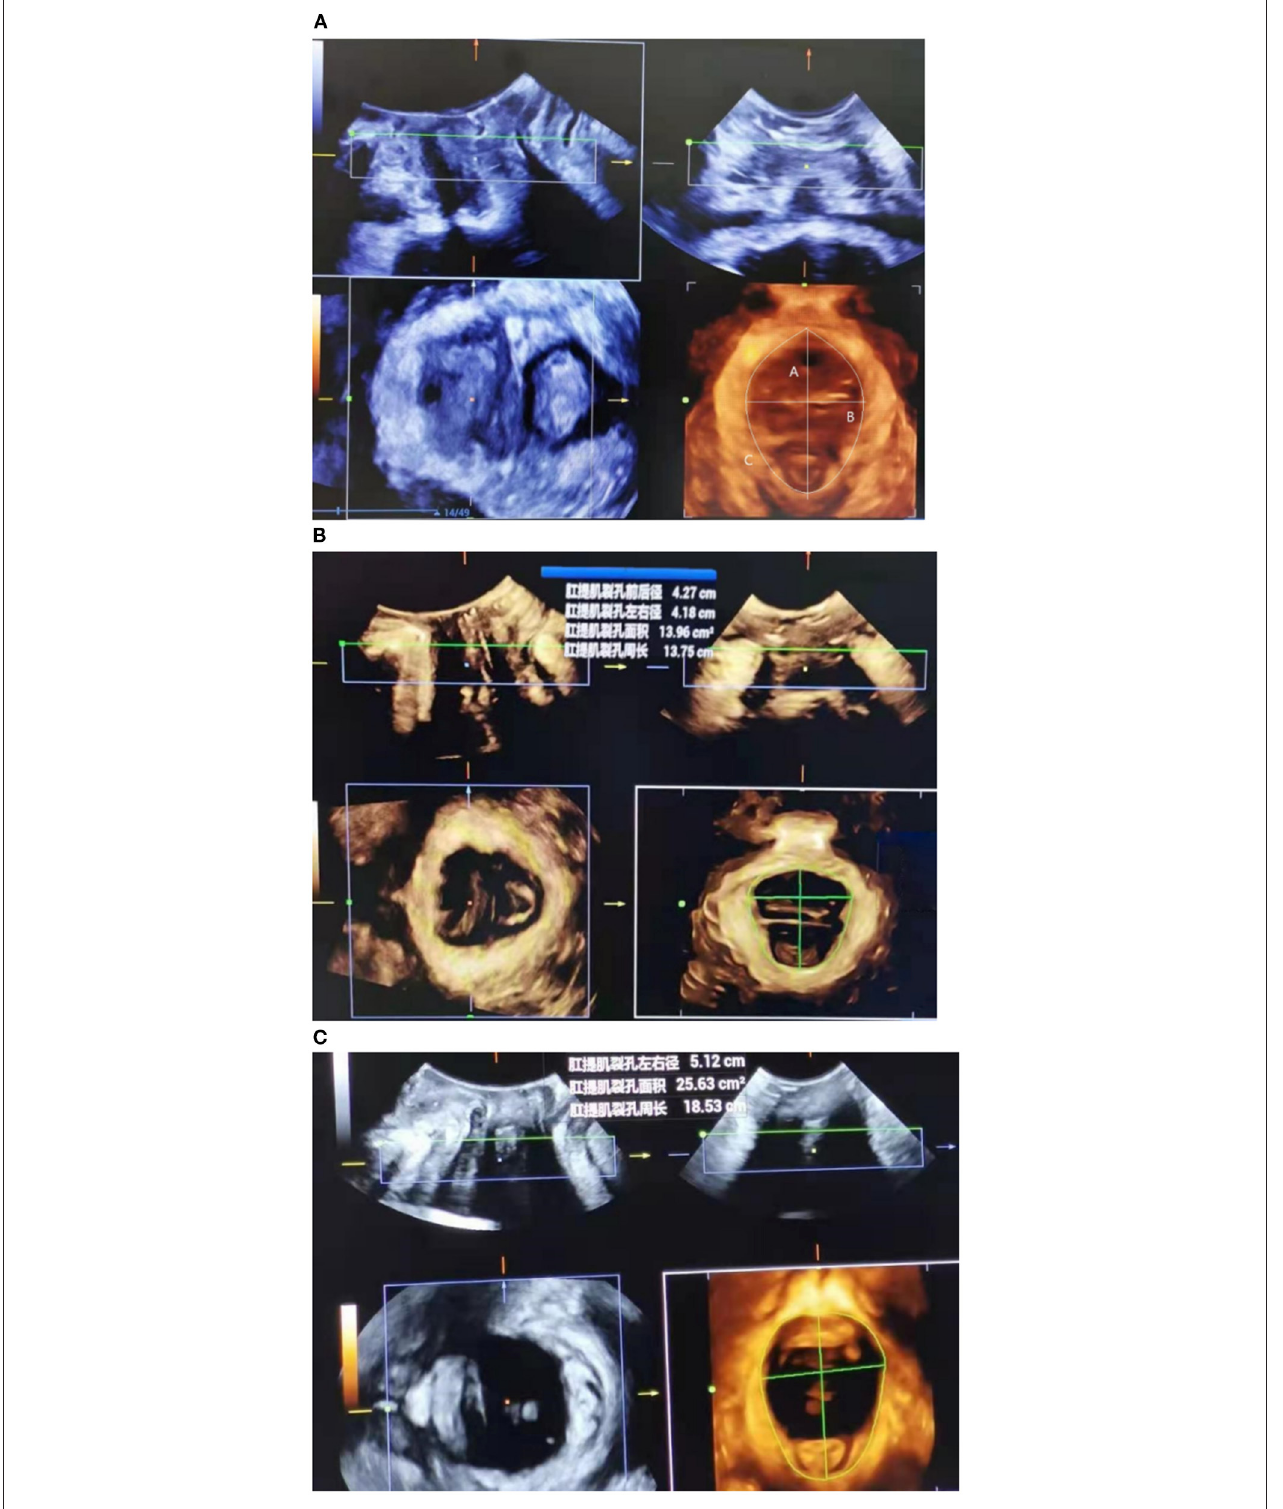
FIGURE 2 | Transperineal ultrasound image demonstrating the measurement of levator hiatal anteroposterior diameter (upper left), left-right diameter (upper right), and area (lower left) at rest (A) , at maximal contraction (B) , or under Valsalva maneuver (C) .